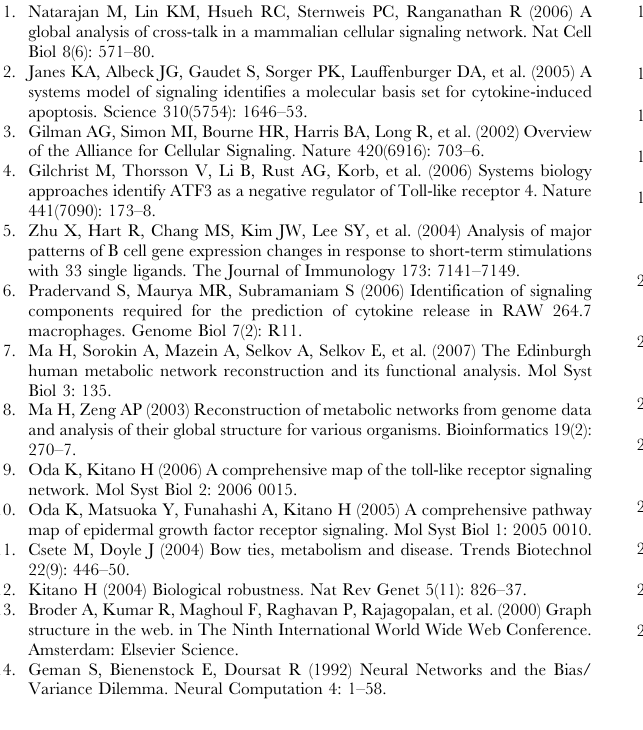
Figure S4 The common and specific transcription factor binding sites (TFBS) found in 2 YES/NO and NO/YES sub- regions of macrophage. Horizontal axis lists the matrices names, which former parts (like ‘MZF1’ in MZF1_01) indicate the TFBS name and the latter parts (like ‘_01’ in MZF1_01) point to the experimental-base quality of the matrices in the descending order from ‘1’ to ‘6’. From the top 30 TFBS we selected matrices within the quality index range from 1 to 4. Asterisks* indicate known regulators of the Immune System, which constitutes 23% of the total number of TFBS (9/39) selected for macrophage. The respective numbers of genes in the right-down corner indicate the numbers of genes which promoters were subjected to the transcriptional analysis and depicted in Figure 5 of the manuscript. Found at: doi:10.1371/journal.pone.0004189.s006 (2.37 MB